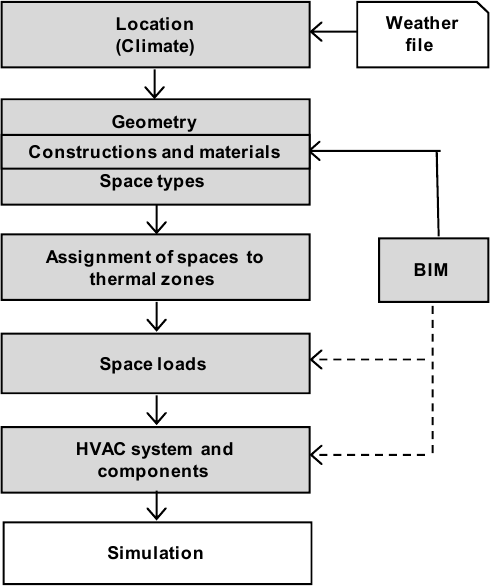
Figure 4. An ideal workflow for energy performance in thermal simulation tools